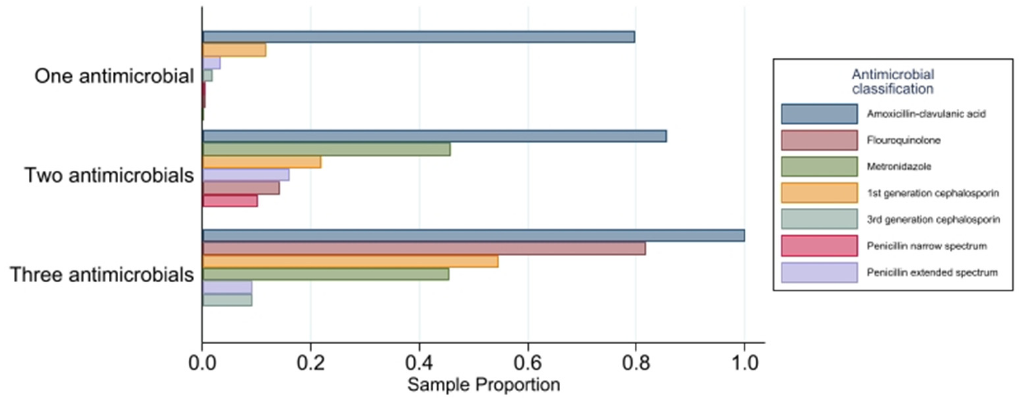
Figure 1. Sample proportions of antimicrobials by the number of oral and parenteral antimicrobials prescribed (omitted one dog with four antimicrobials dispensed). Table 2. Number of events prescribed antimicrobials and route of administration in dogs which presented for treatment of dog-to-dog bite wounds from 1998 to